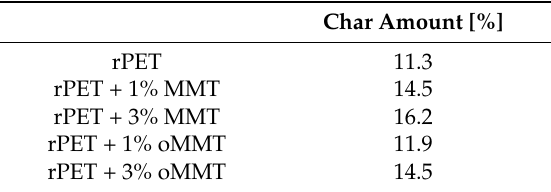
Figure 5. Thermogravimetric curves of the nanocomposites (N 2 atmosphere, 20 ◦ C/min). Table 4. Char amounts formed from thermogravimetric analysis (TGA).